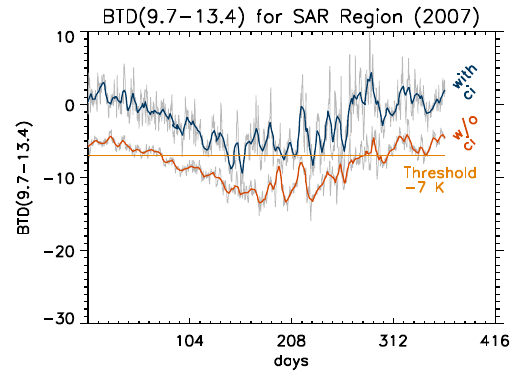
Fig. 4. Mean daily BTD T 9 . 7 − T 13 . 4 for those SEVIRI pixels that have been detected as cirrus covered (blue) or cirrus free (red) by MeCiDA Tests 1–5 over SAR as a function of time during the year 2007. Grey curves represent the same BTD but with the full tempo- ral resolution of